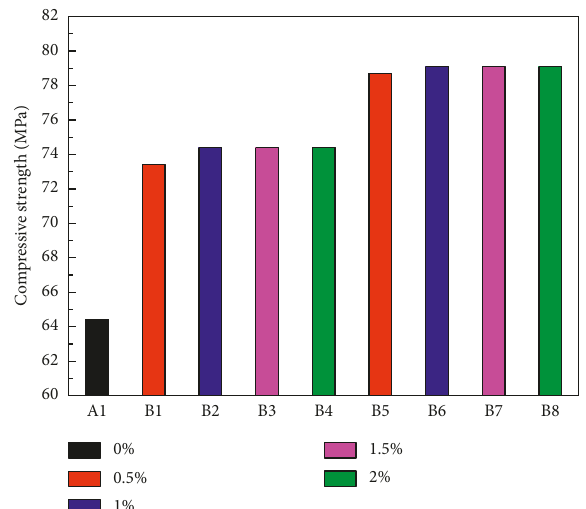
Figure 4: Compressive strength corresponding to different cou- pling agent contents.